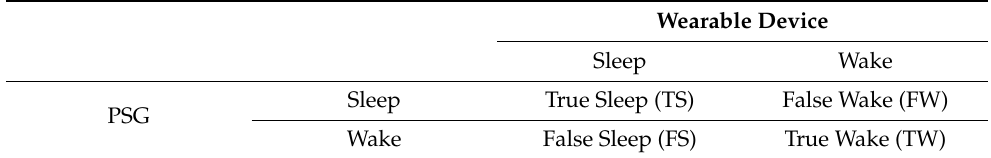
Table 1. Sleep/wake agreement matrix.